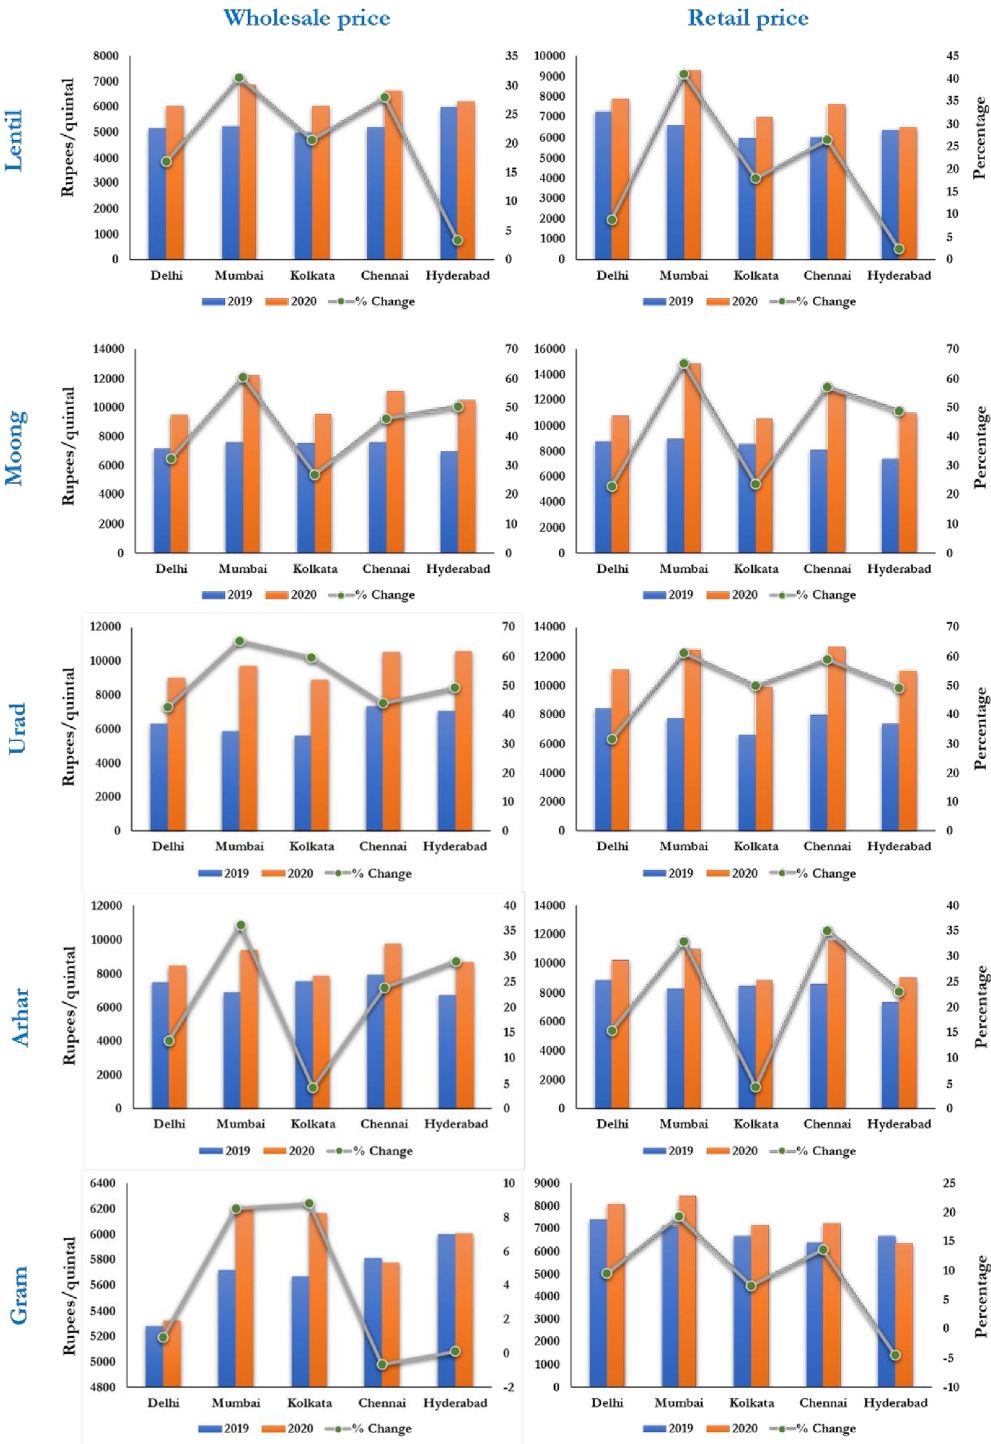
Fig 2. Average price and % change in price of pulses in different markets of India. Note: % change indicates the percentage change in prices during lockdown period of 2020 compared to the same period in 2019.